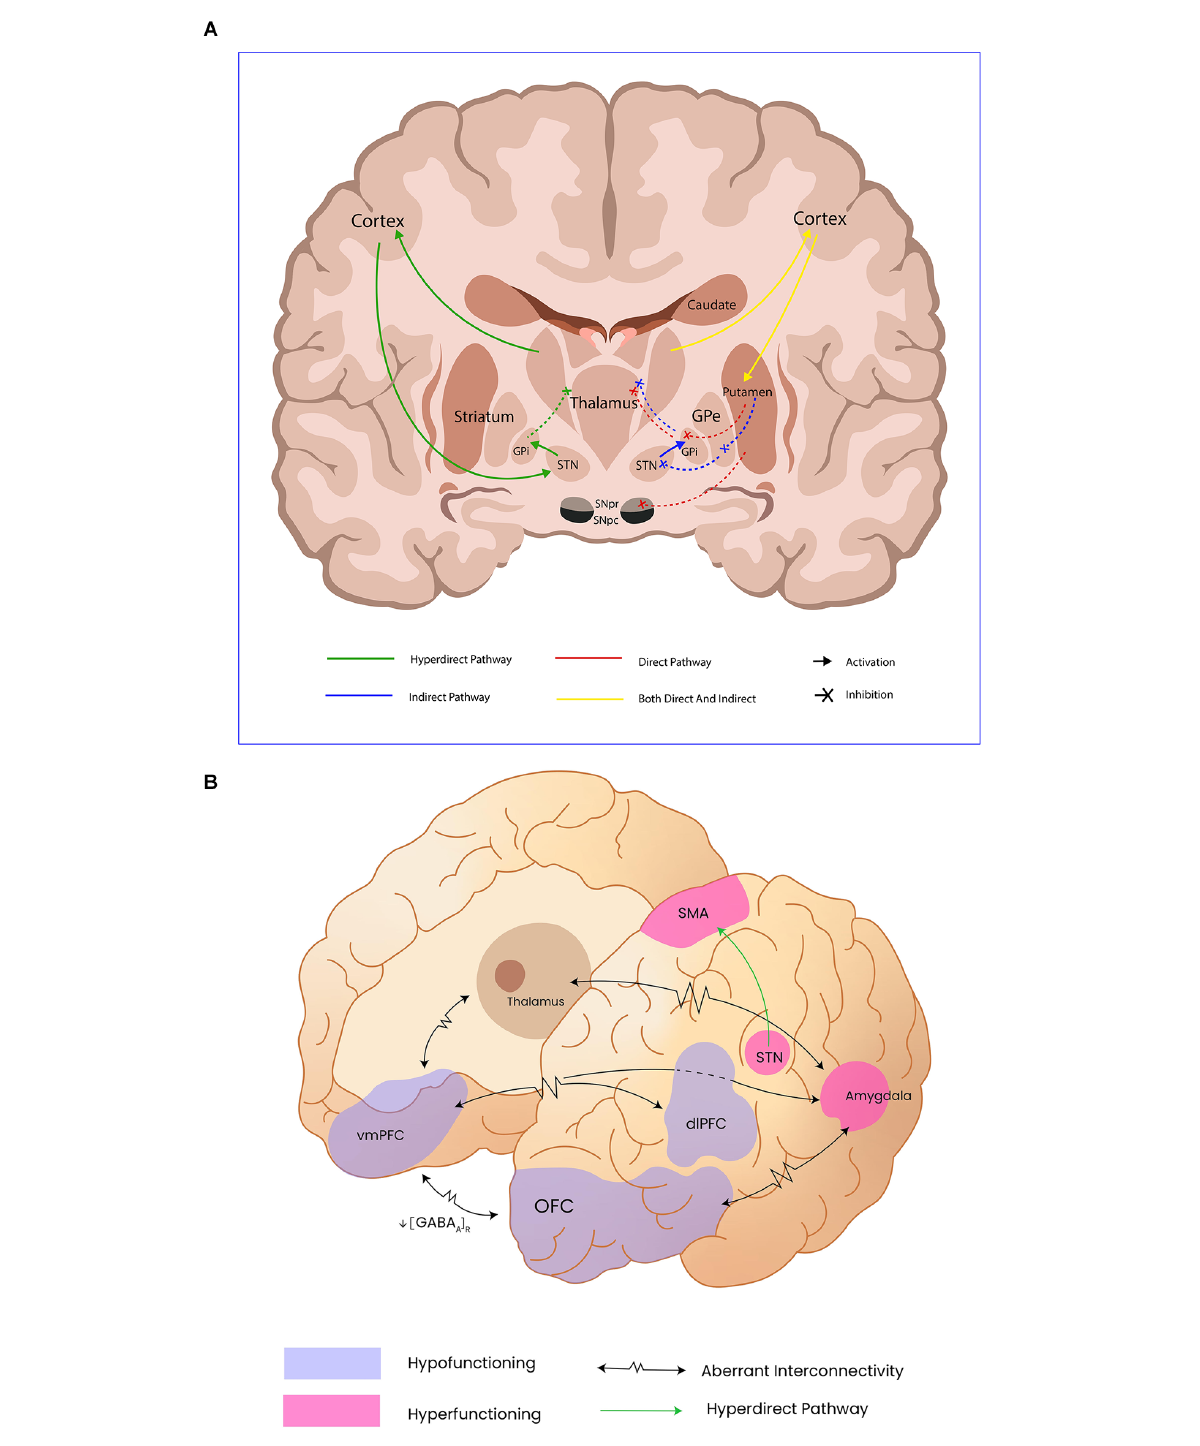
FIGURE1 Panel (A) shows motor control pathways and the cortical and subcortical structures involved in movement control; Internal Globus pallidus (GPi), External Globus Pallidus (GPe), Subthalamic nucleus (STn). Panel (B) illustrates the abnormal functioning of cortical and subcortical structures reported by functional neuroimaging as well as the aberrant connectivity in catatonia; Orbitofrontal cortex (OFC), ventromedial prefrontal cortex (vmPFC), and dorsolateral prefrontral cortex (dlPFC) have been addressed as hypofunctioning, probable due to diminished GABAa receptor density. Subthalamic nucleus (STn), supplementary motor area (SMA), and the amygdala remain hyperfunctioning in catatonic patients, leading to motor